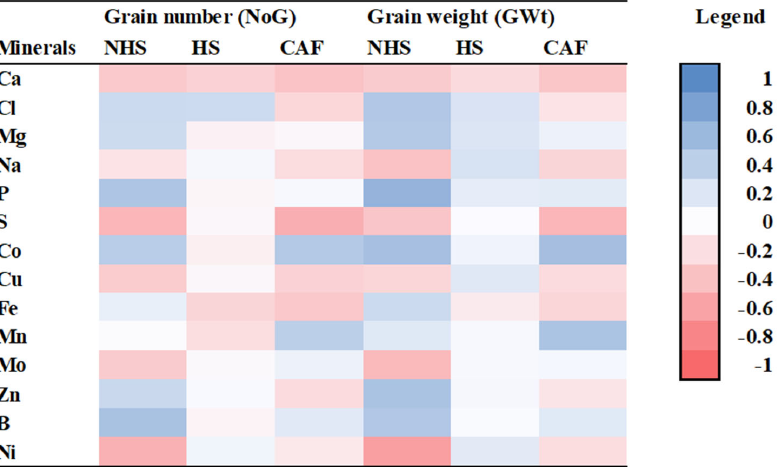
Figure 6. The correlation coefficients between grain mineral concentrations and yield for the growth environment and general treatment interactions. NHS—non ‐ heat ‐ stressed environment, HS—heat ‐ soil